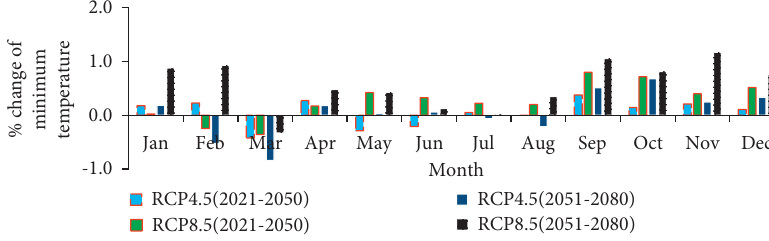
Figure 12: Change in average monthly minimum